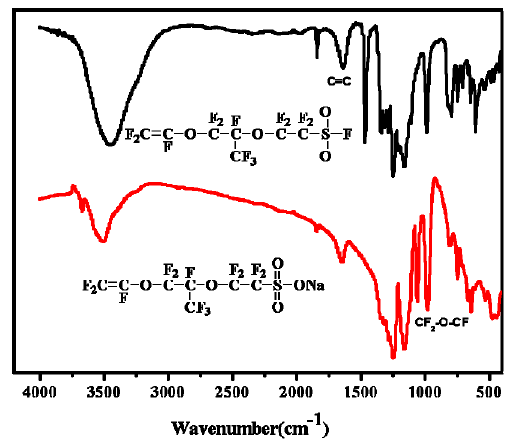
Figure 1. FTIR spectra of perfluoro (4–methyl–3, 6–dioxaoct–7–ene) sulfonyl fluoride (PSVE) and